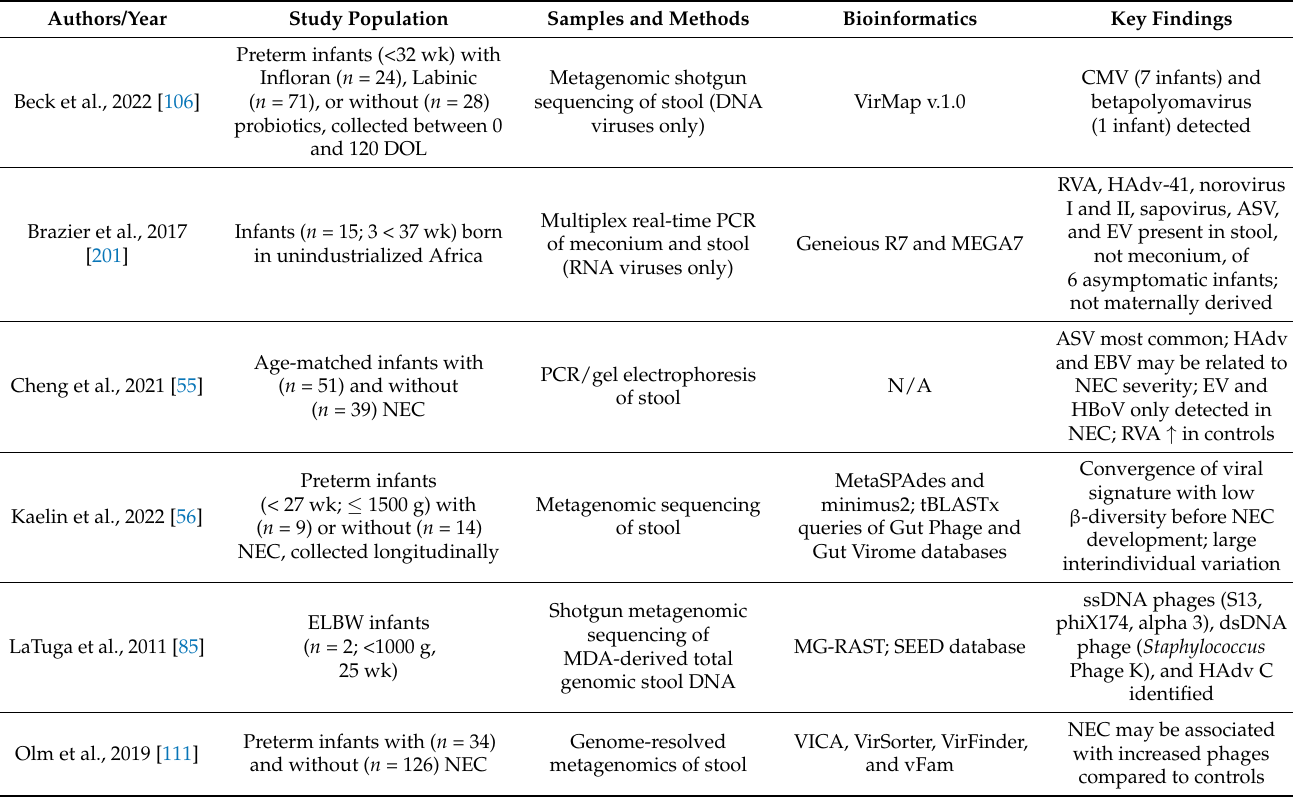
Table 2. Overview of key preterm infant gut viral sequencing